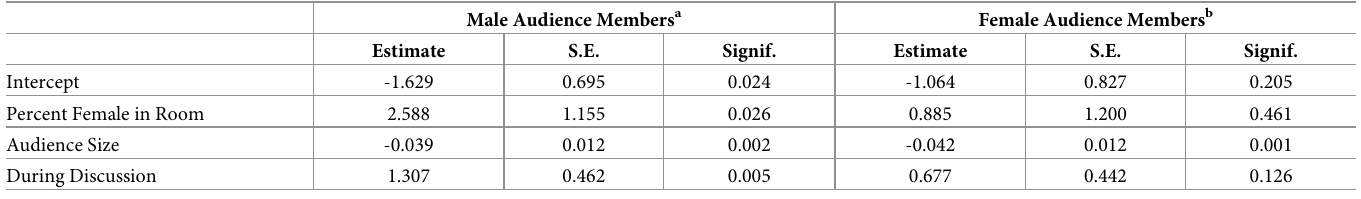
Table 4. Results of mixed logistic models testing effect of gender ratio on likelihood of asking